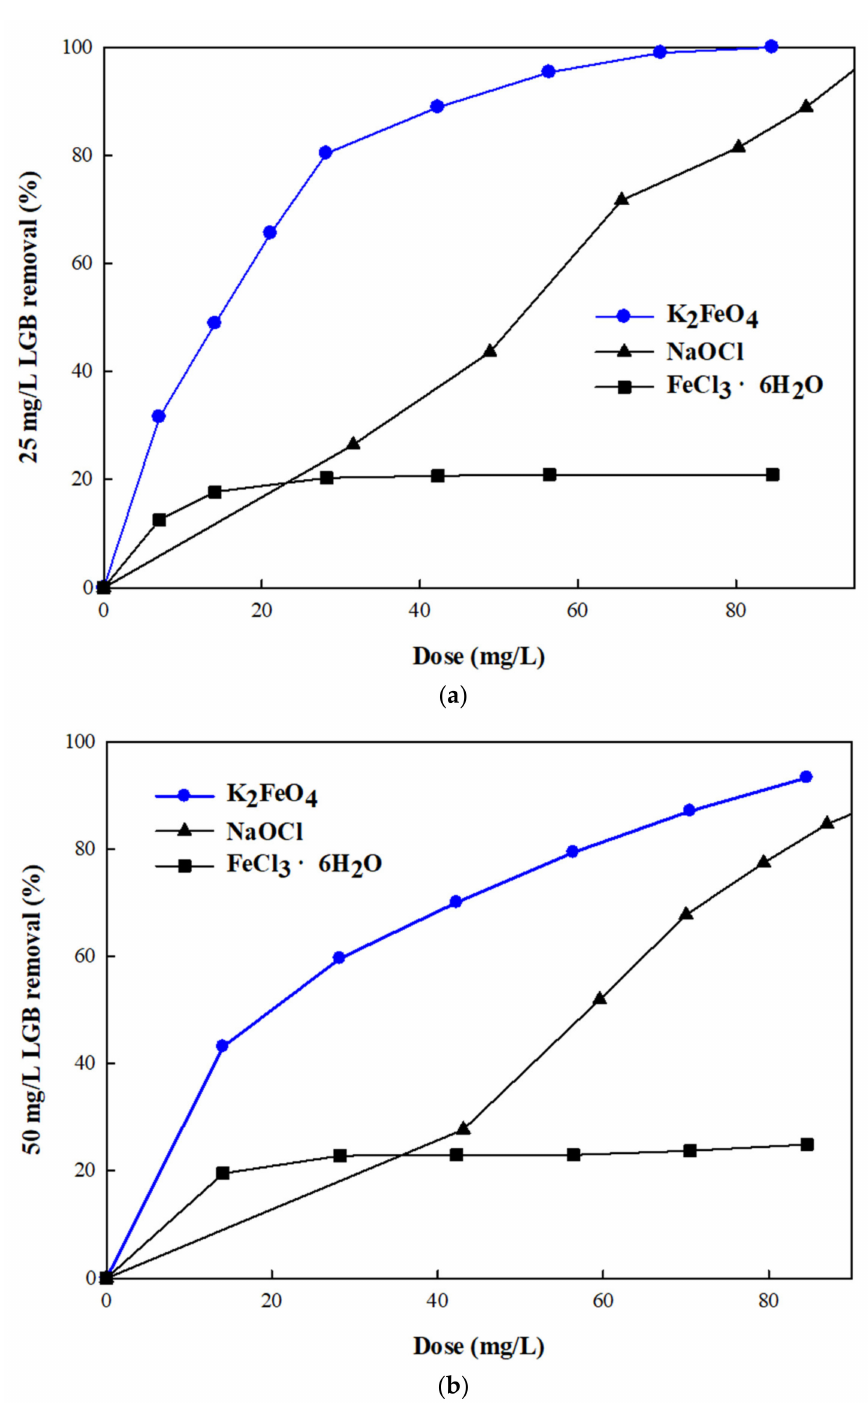
Figure 5. Comparison of potassium ferrate with NaOCl and FeCl 3 · 6H 2 O with respect to the removal efficiency of ( a ) 25 mg/L and ( b ) 50 mg/L of lissamine green B dye at pH 3. At the dose of 30 mg/L, K 2 FeO 4 reacted more actively with 25 mg/L of LGB than with 25 mg/L of OD, corresponding to 80% of LGB and 61% of OD removal efficiencies. However, 90% removal of OD (25 mg/L) was achieved at a K 2 FeO 4 dose of 40 mg/L,